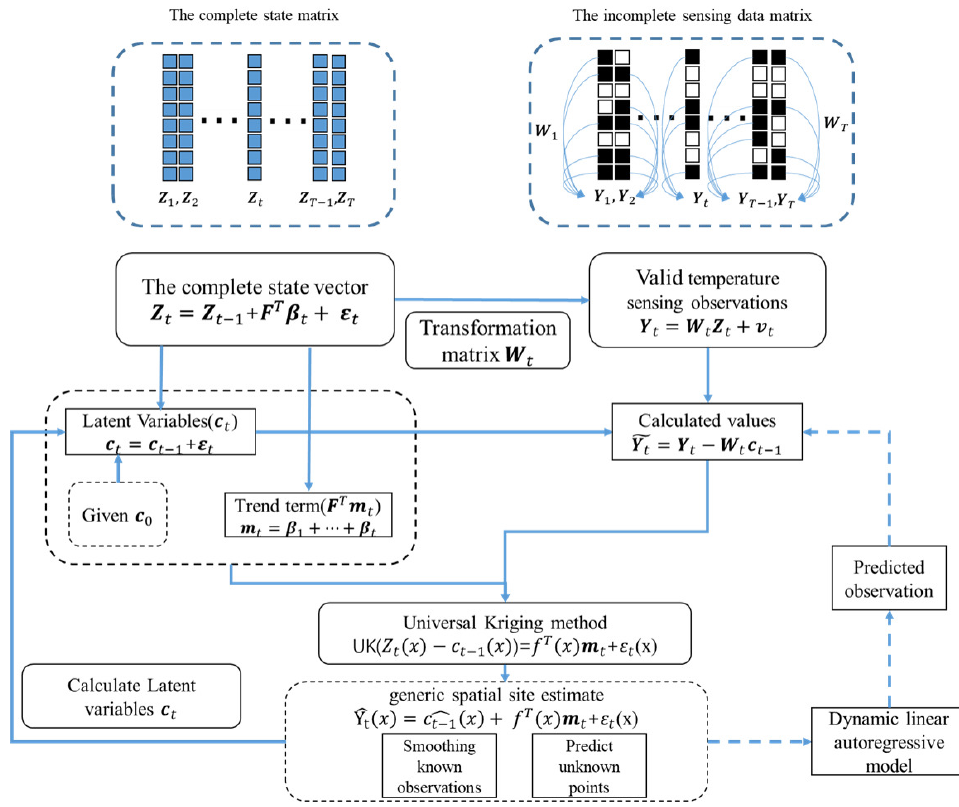
Figure 2. Flexible Universal Kriging state-space model flow